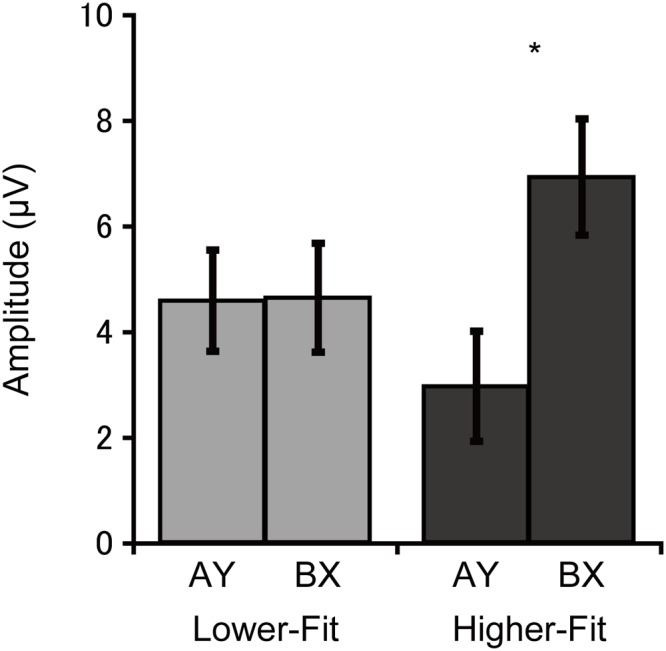
Mean (SE) cue-P3 amplitude for each group and trial type collapsed across electrode sites, illustrating the Group × Trial interaction. Bonferroni-corrected post hoc comparisons between trial types: ∗p < 0.025.